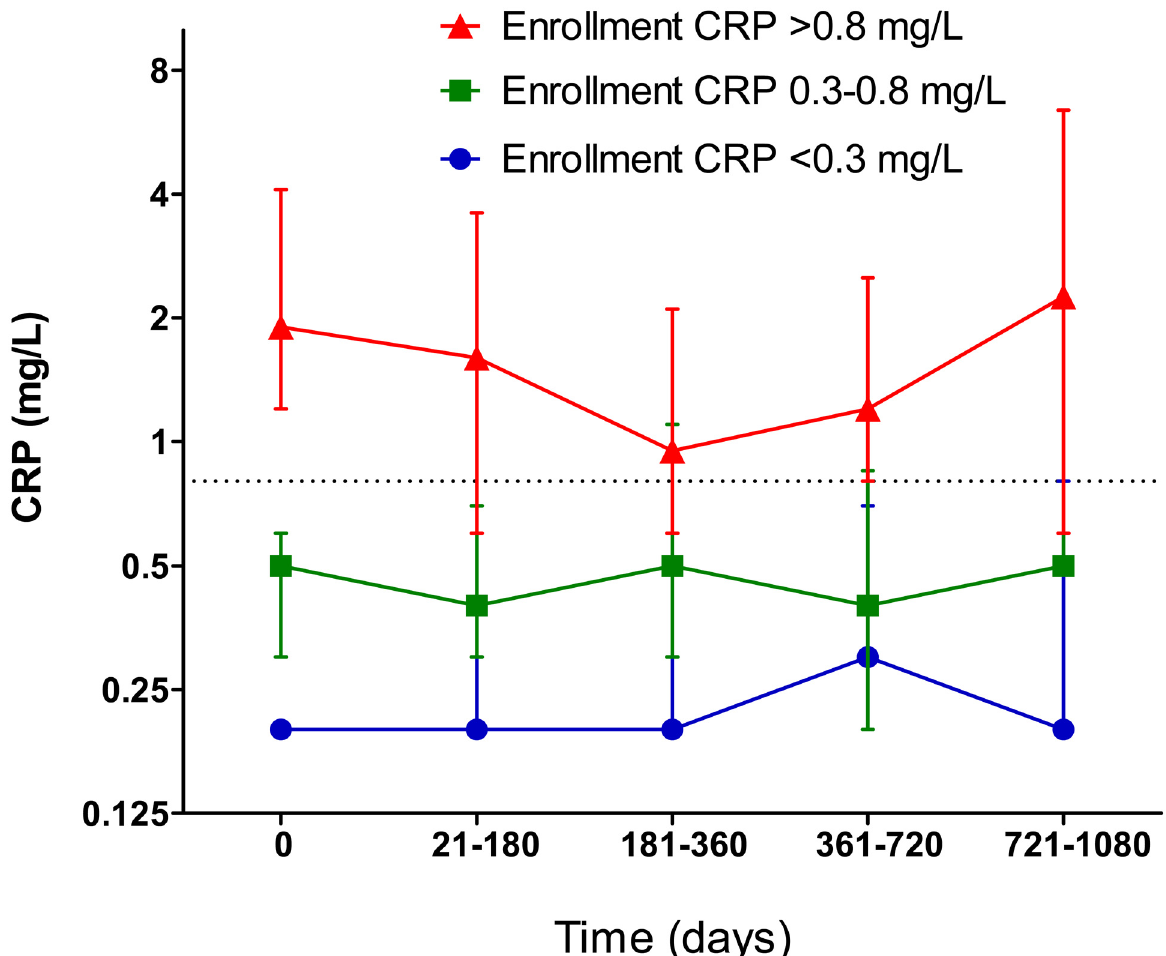
Fig 1. Serial changes in CRP levels in patients with low, mid, and high baseline CRP concentrations. CRP was measured at study enrollment and during the follow-up period (21 – 180 days, 181 – 360 days, 361 – 720 days, and 721 – 1080 days after study enrollment). Patients were assigned to three groups: those with low-level ( < 0.3 mg/L), mid-level (0.3 – 0.8 mg/L), and high-level ( > 0.8 mg/L) CRP at enrollment. Data represent median, and top and bottom error bars represent 75 and 25 percentile values, respectively.